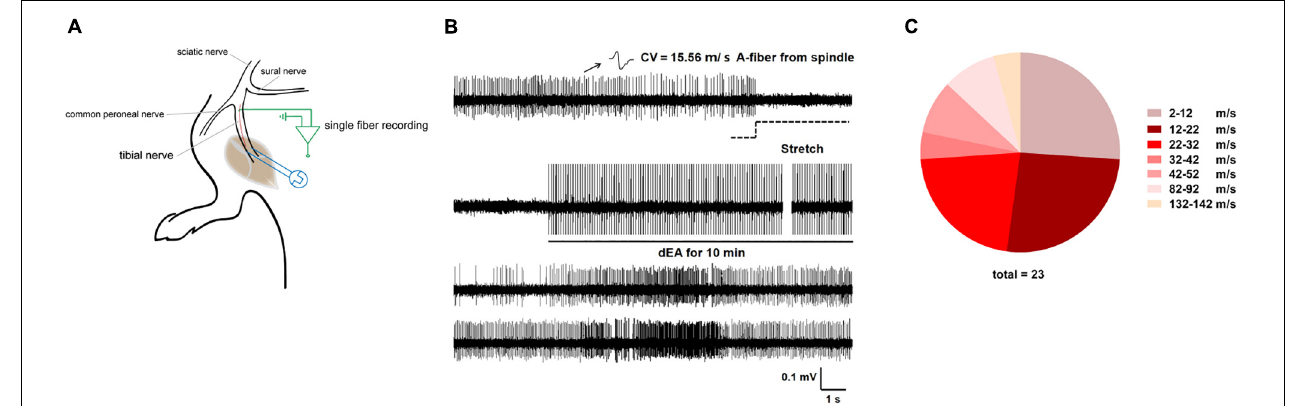
FIGURE 2 | Deep electroacupuncture (dEA) activated numerous muscular A-fiber afferents from the gastrocnemius. (A) Schematic of in vivo recording for single fiber teased out from the tibial nerve innervating the gastrocnemius. (B) Representative single A-fiber [conduction velocity (CV) = 15.56 m/s] spontaneous activity originated from muscle spindle, and its robust discharges responded to muscular stretch and dEA. (C) Distribution of afferent fibers evoked by dEA according to CV. dEA activated numerous muscular A-fibers (26.96 ± 6.50 m/s, n = 23 fibers).